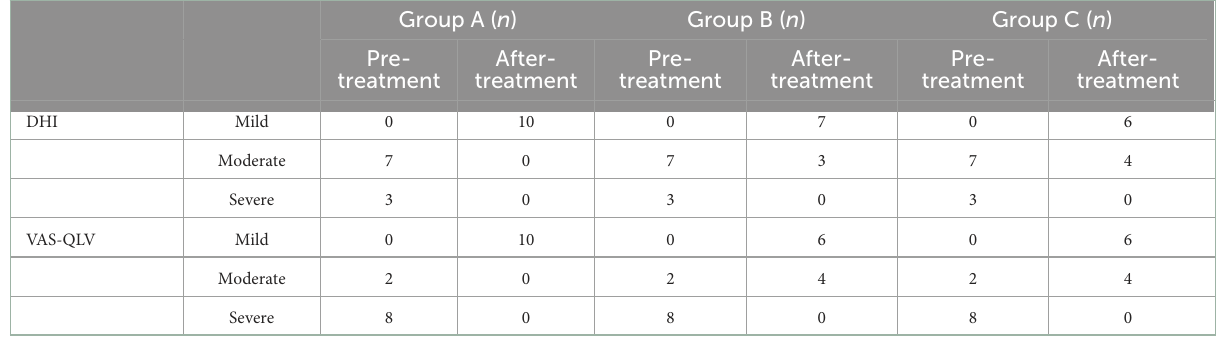
TABLE 3 Results of two-way ANOVA of CP.